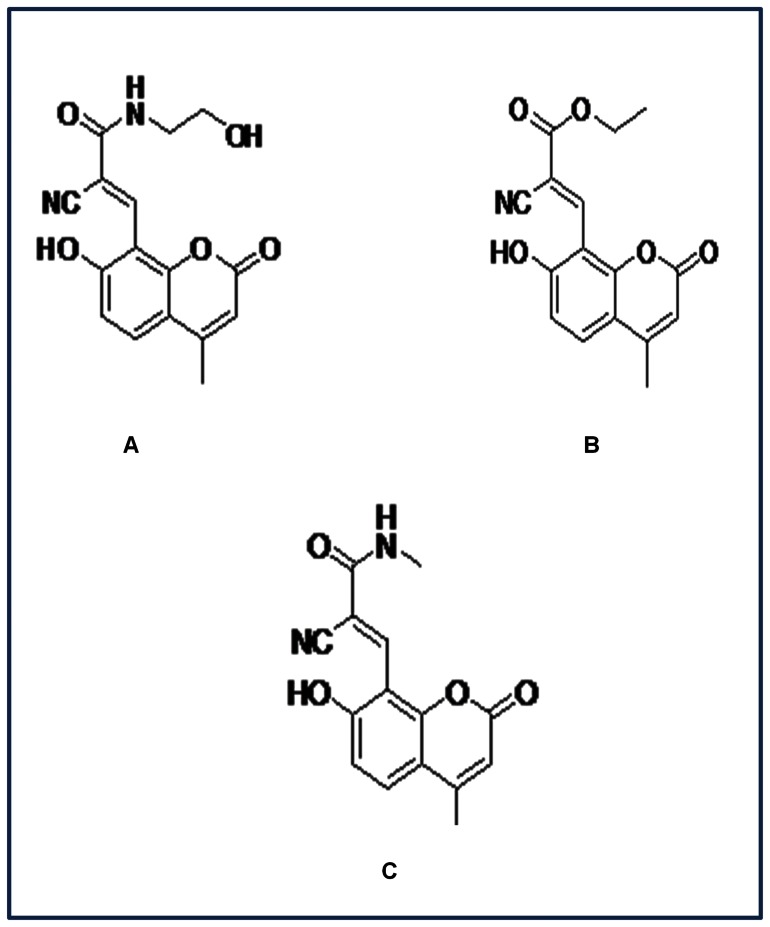
Chemical structures of 7-hydroxy-4-methyl coumarin derivatives with their IUPAC names.A) (2E)-2-cyano-N-(2-hydroxyethyl)-3-(7-hydroxy-4-methyl-2-oxo-2H-chromen-8-yl) prop-2enamide (CD enamide). Molecular mass-314.29 Da. Molecular formula- C16H14N2O5. B) Ethyl (2E)-2-cyano-3-(7-hydroxy-4-methyl-2-oxo-2H-chromen-8-yl) prop-2-enoate (CD enoate). Molecular mass- 299.28 Da. Molecular formula- C16H13NO5. C) (2E)-2-cyano-3-(7-hydroxy-4-methyl-2-oxo-2H-chromen-8-yl)-N-methylprop-2-enamide (CDM enamide). Molecular mass- 284.27 Da. Molecular formula- C15H12N2O4.